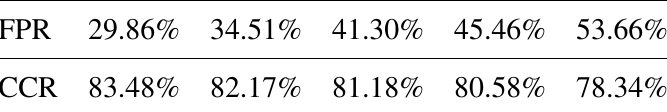
Table 4. The CCRs of the GHA and FCM algorithms for spike detectors with different FPRs at SNR = 1